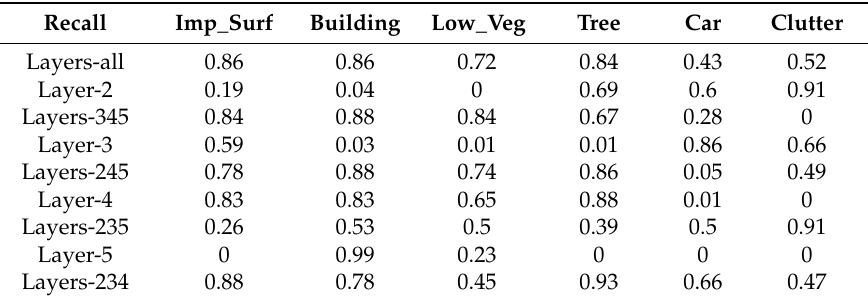
Table 1. The recall of different layers for different classes in